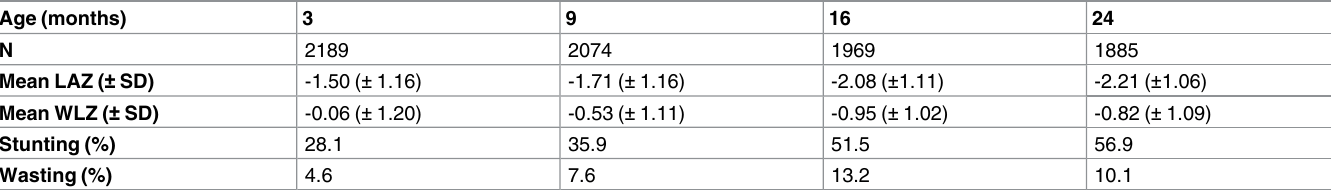
Table 2. Nutritional status by infant age in Kishoreganj, Bangladesh.